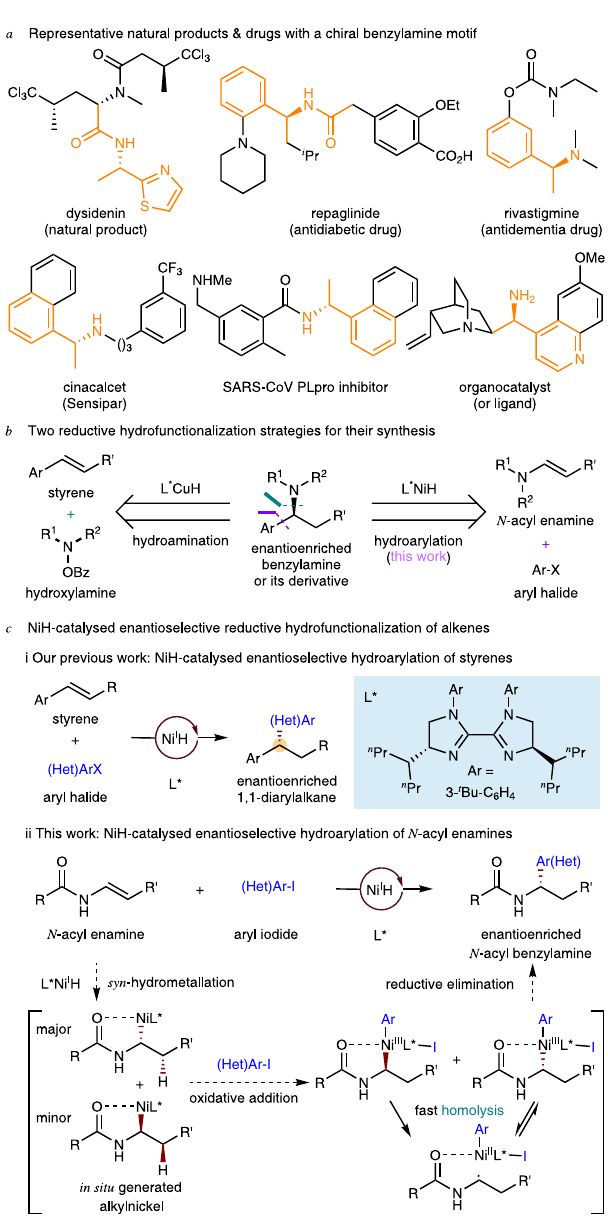
Fig. 1 Asymmetric hydroarylation of N -acyl enamines to access chiral benzylamines. a Representative natural products & drugs with a chiral benzylamine motif. b Two reductive hydrofunctionalization strategies for their synthesis. c NiH-catalyzed enantioselective reductive hydrofunctionalization of